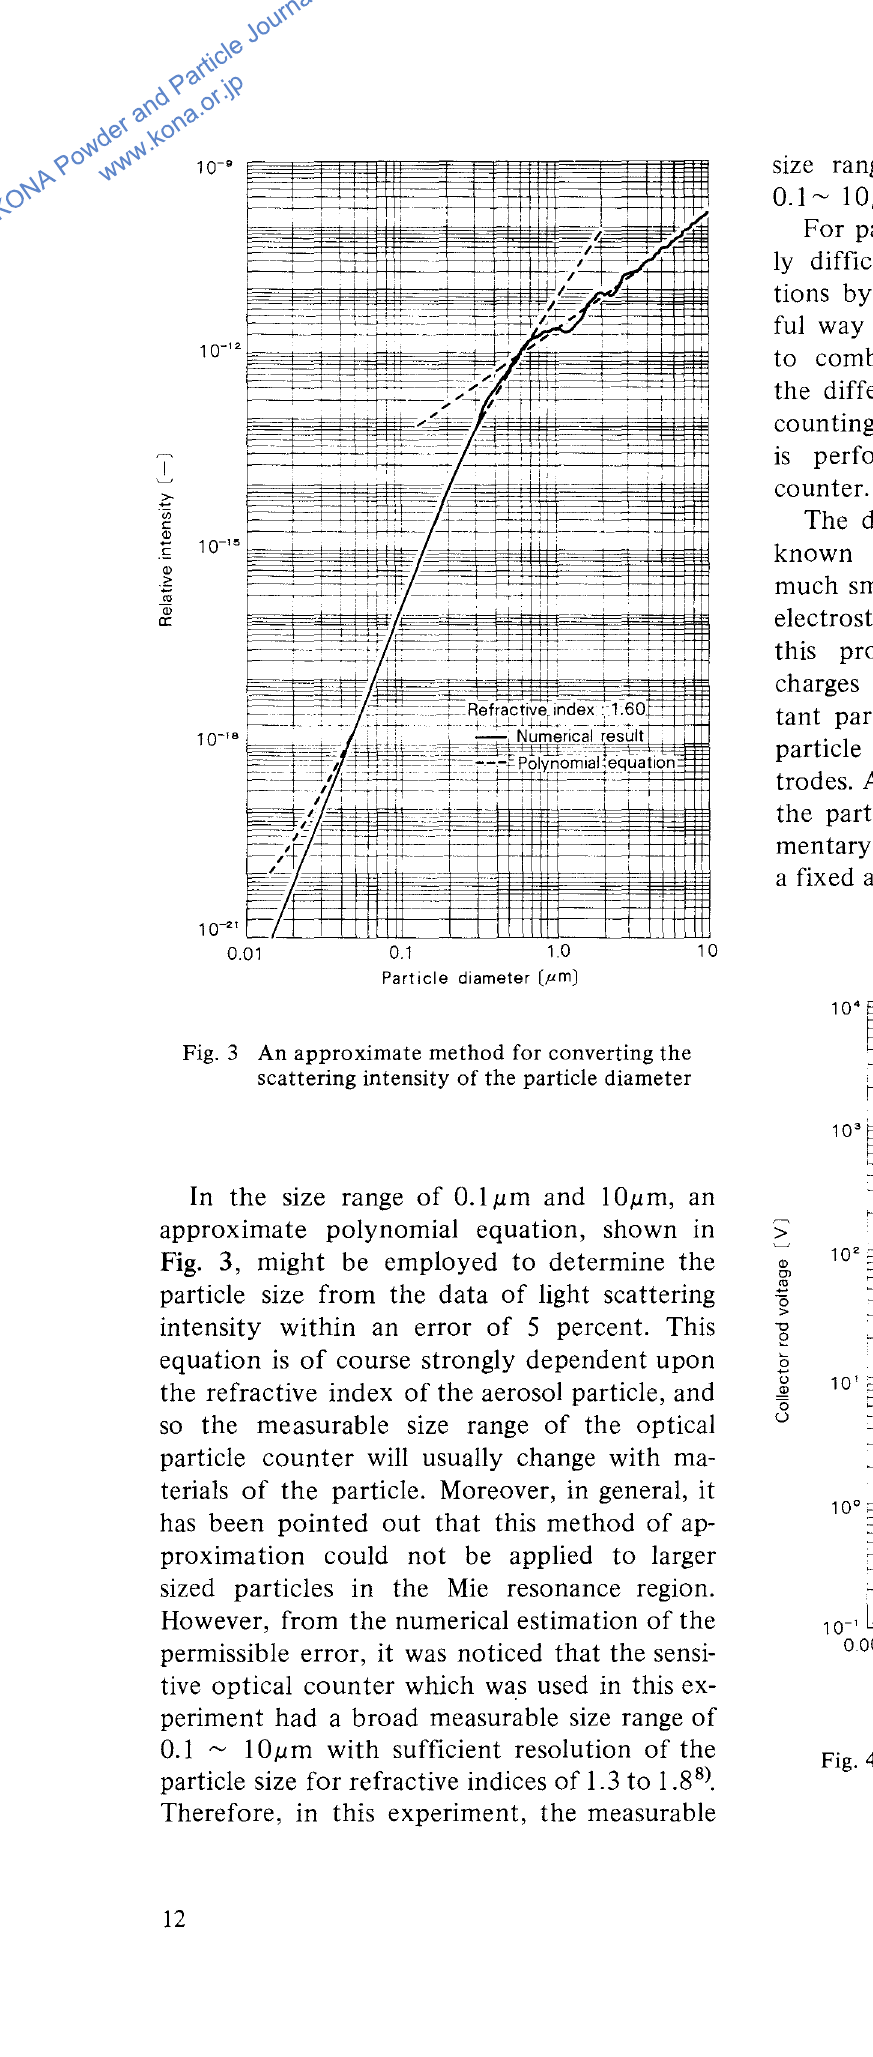
Fig. 4 Collector rod voltage of the differential mobility analyzer as a function of parti cle diameter